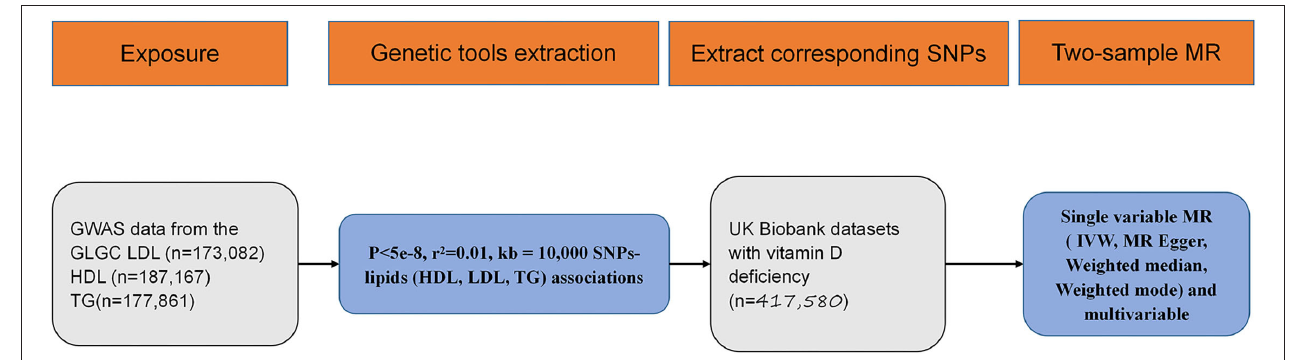
FIGURE 1 | Flow diagram for eligible single nucleotide polymorphism (SNPs) selection for exposure and outcome. SNP, single nucleotide polymorphism; GWAS, genome wide association study; MR, mendelian randomization; HDL, high density lipoprotein; LDL, low density lipoprotein; TG, triglycerides; IVW, inverse variance weighted.